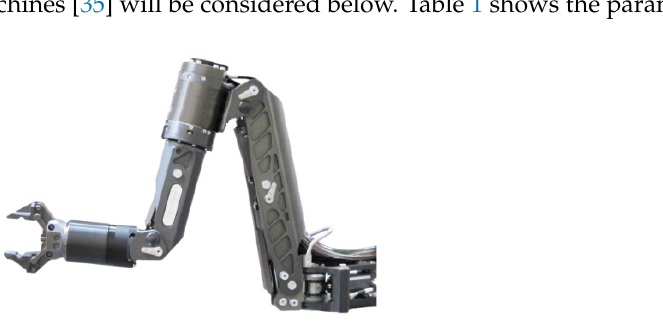
Figure 6. Six ‐ link robot «Orion 7R» kinematic scheme [35]. Figure 6. Six-link robot «Orion 7R» kinematic scheme [35]. Table 1. Manipulator link